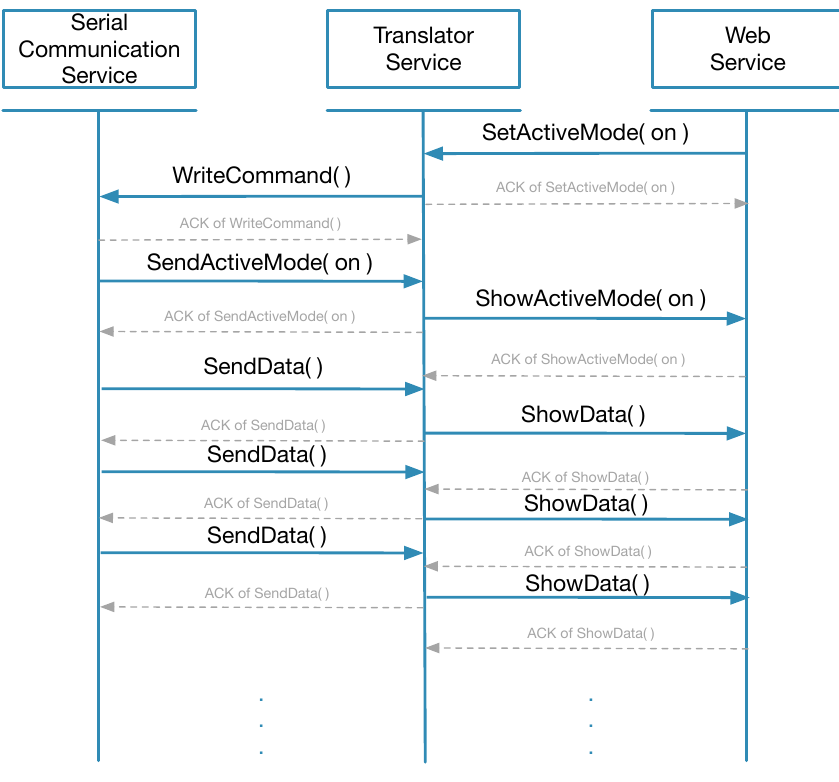
Figure 5. Active mode.